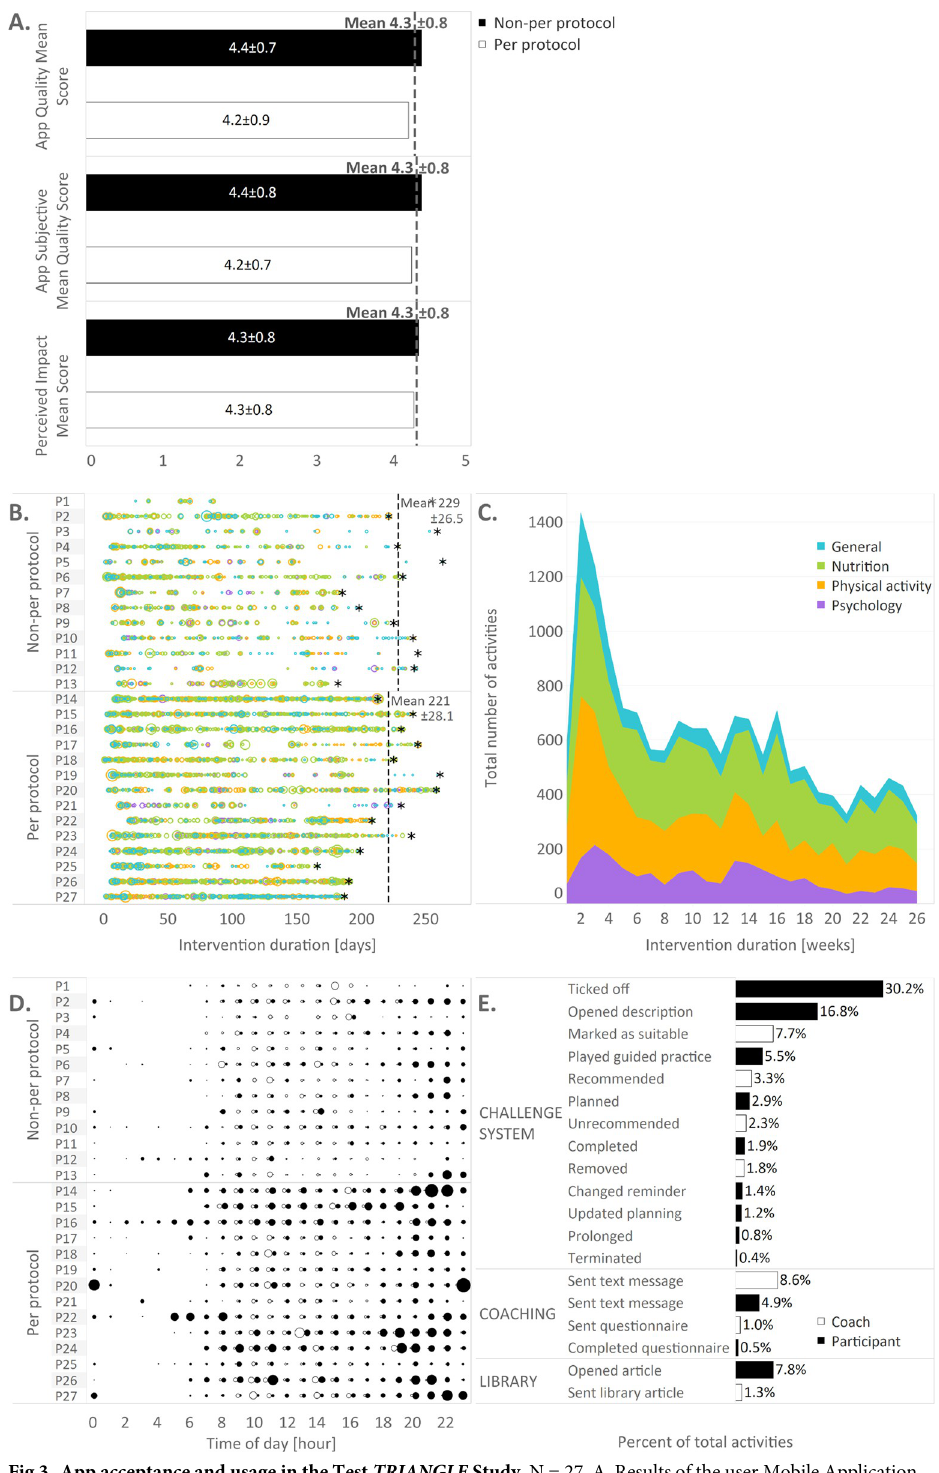
Fig 3. App acceptance and usage in the Test TRIANGLE Study. N = 27, A. Results of the user Mobile Application Rating Scale (uMARS), black bars = non-per-protocol group (n = 13); white bars = per-protocol group (n = 12, two missing); all values as mean ± standard deviation, B. Number of app activities per participant over time; n = 13 in the non-per-protocol group (top) and n = 14 in the per-protocol group (bottom); one circle per active day, circle size reflects number of activities, asterisk marks visit 2, P = participant; C. Proportion of total number of app activities over